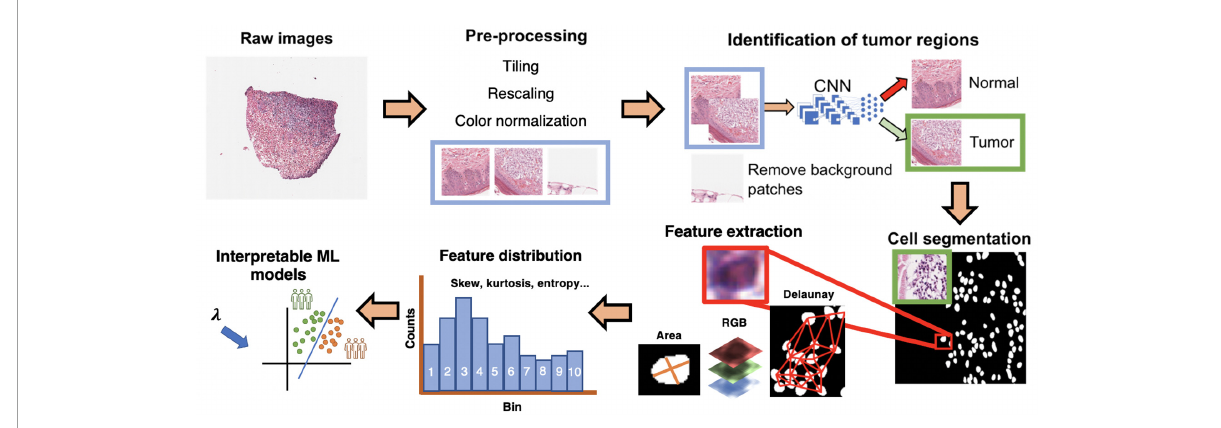
FIGURE1 Interpretable cell morphology and machine learning pipeline. Whole slide images are tiled into 512 × 512 pixel patches and then rescaled for differences in resolution between datasets, background patches are removed by manually engineered color features, and tumor/normal regions are identified using a convolutional neural network that was trained with pathologist annotations. Tiles then normalized for hematoxylin and eosin (H&E) staining, and cells segmented with StarDist. Cell masks are analyzed with MATLAB to generate measures of cell morphology (e.g., area), tissue architecture (i.e., Delaunay distance), and identify small, hyperchromatic cells. 50 processed slides are randomly pooled, and k-means clustering ( k = 10) is used to bin the distribution of each image feature and five distribution statistics are calculated (e.g., skew, kurtosis, mean). Finally, every cell of every slide is assigned the “bins” to generate a final dataset of N patients × 135